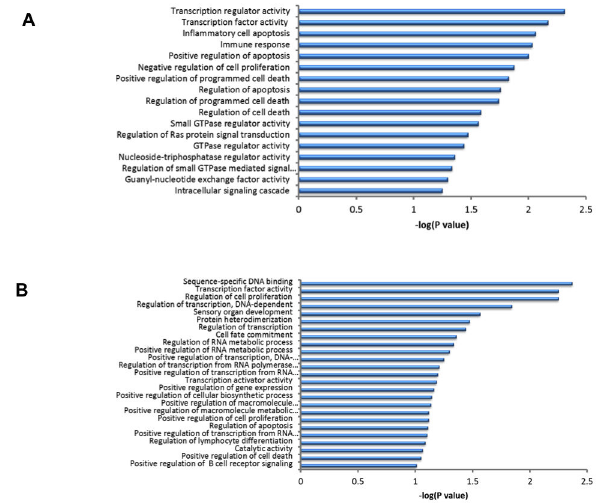
Figure 5. Significant molecular functions associated with genes dependent on Meq expression. The significant molecular functions are given identified through IPA based on the significantly expressed genes that were Meq-dependent and involved in MD resistance (A) and MD susceptibility (B). P <0.05 and FDR<0.05 were used as thresholds.